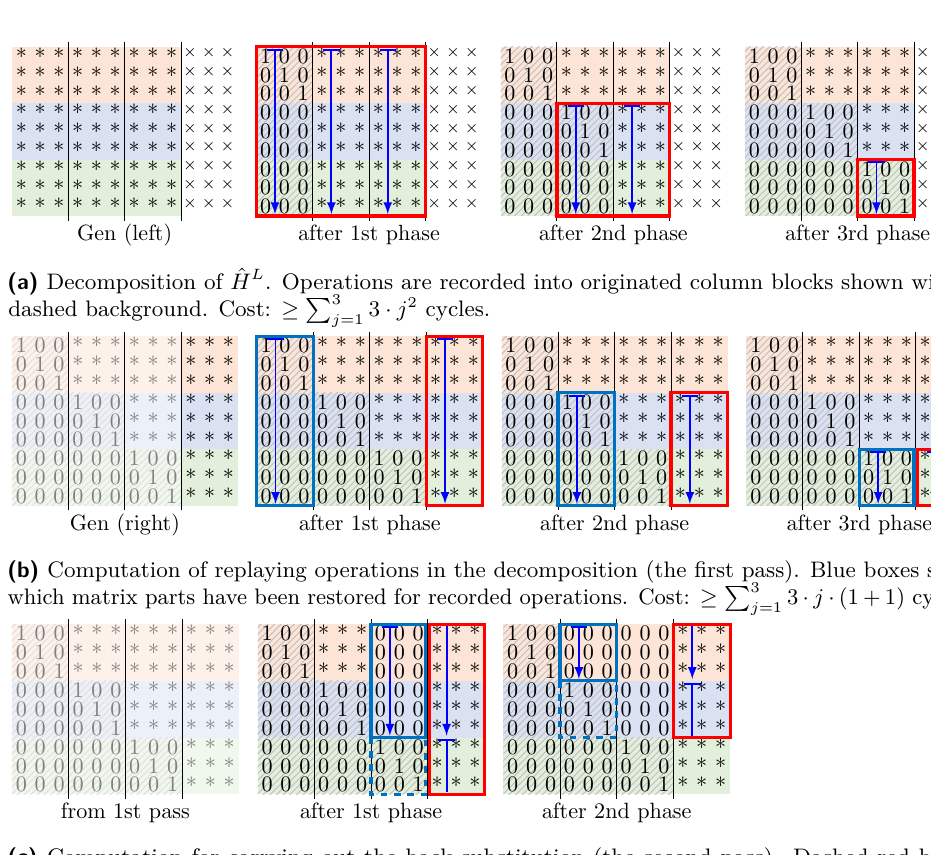
(c) Computation for carrying out the back substitution (the second pass). Dashed red boxes indicate data that is only read but not modified. Cost: ≥ P 2 3 · ( j + ( j + 1)) cycles. j =1 Figure 14: Visualization of DPEA for a 9 × 12 matrix using a column-block size of s = 3. Asterisks denote random data. Corresponding sets of rows are marked in the same color. Red boxes show which matrix parts have been